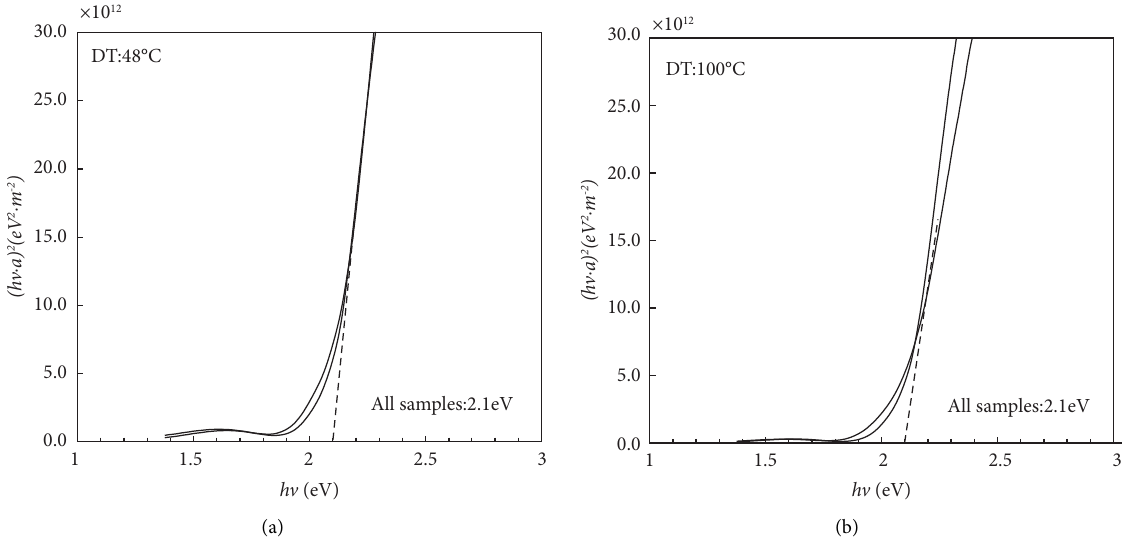
Figure 7: Bandgap of samples (a, b) that formed at 10W on PMMA, PC, and glass